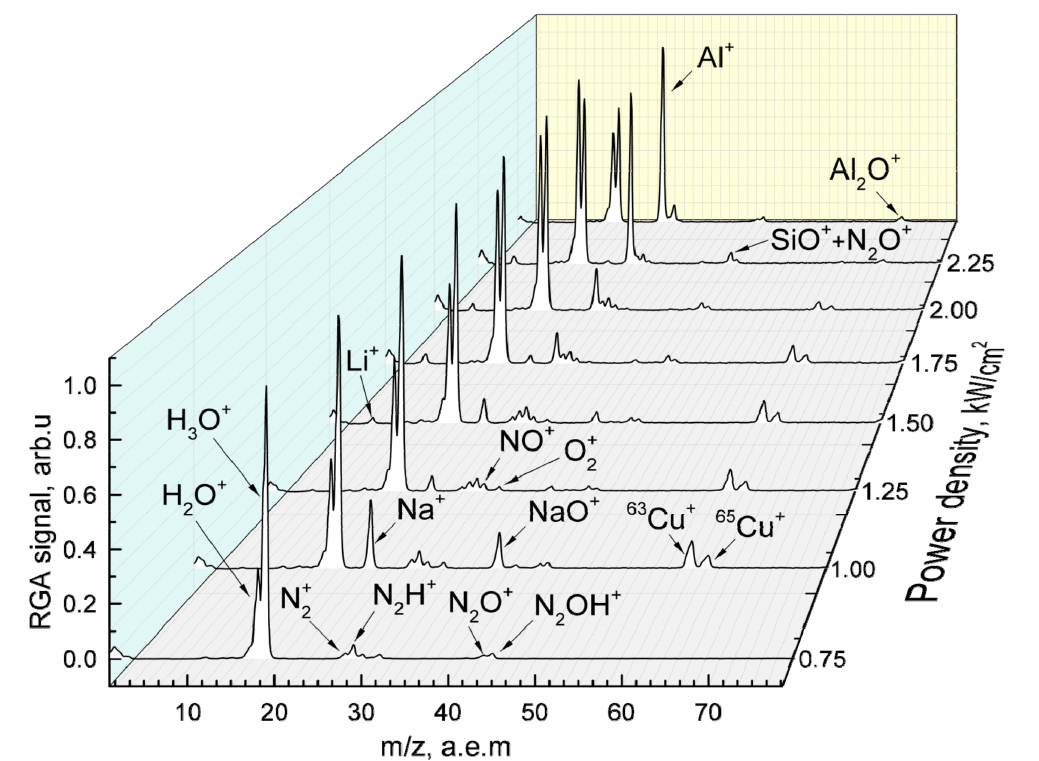
Figure 4. Dependence of the mass-to-charge composition of beam plasma ions on the beam power